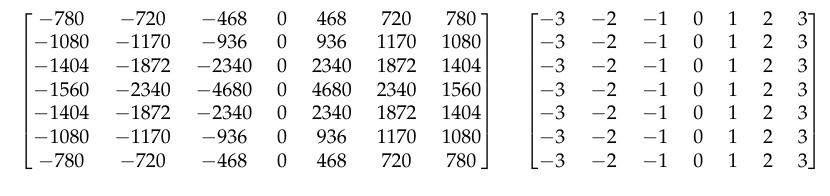
Figure A6. 7 × 7 kernels